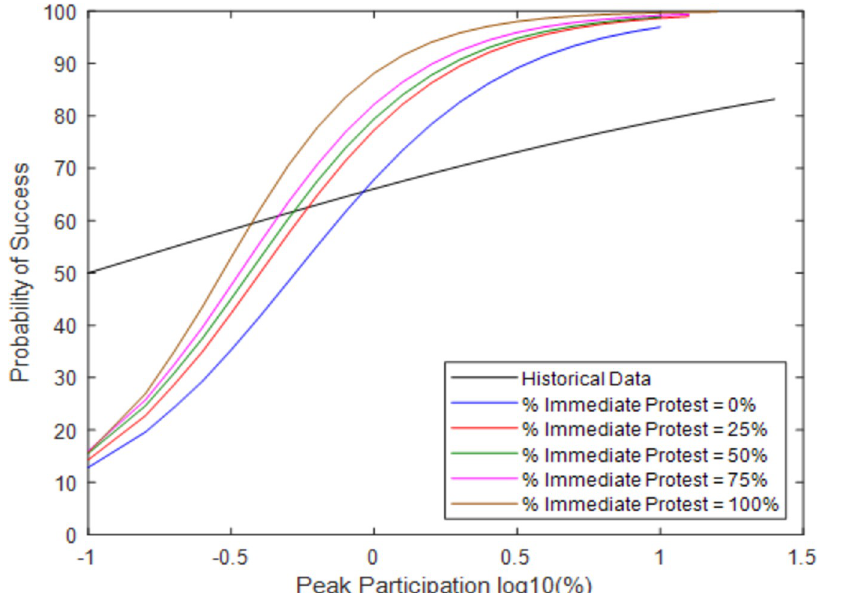
Fig 3. Probability of success at a given peak participation with varying Percent Immediate